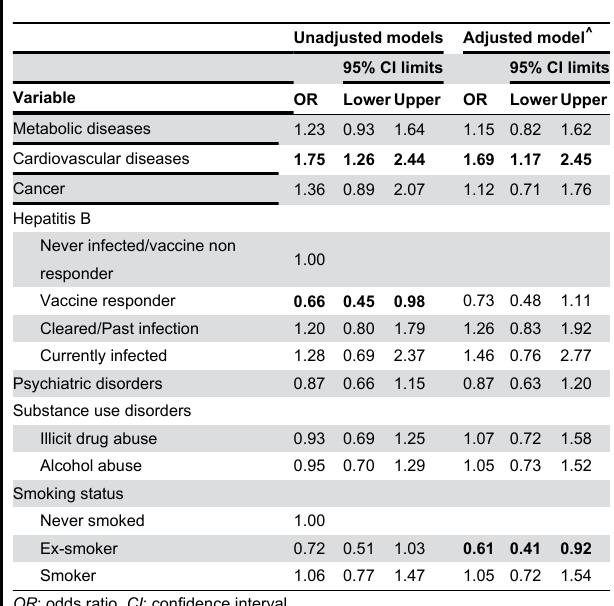
OR : odds ratio, CI : confidence interval ^. Model adjusted for metabolic disease, cardiovascular disease, cancer, hepatitis B, psychiatric disorders, substance use disorders and smoking status. NOTE. Statistically significant ORs are emboldened.